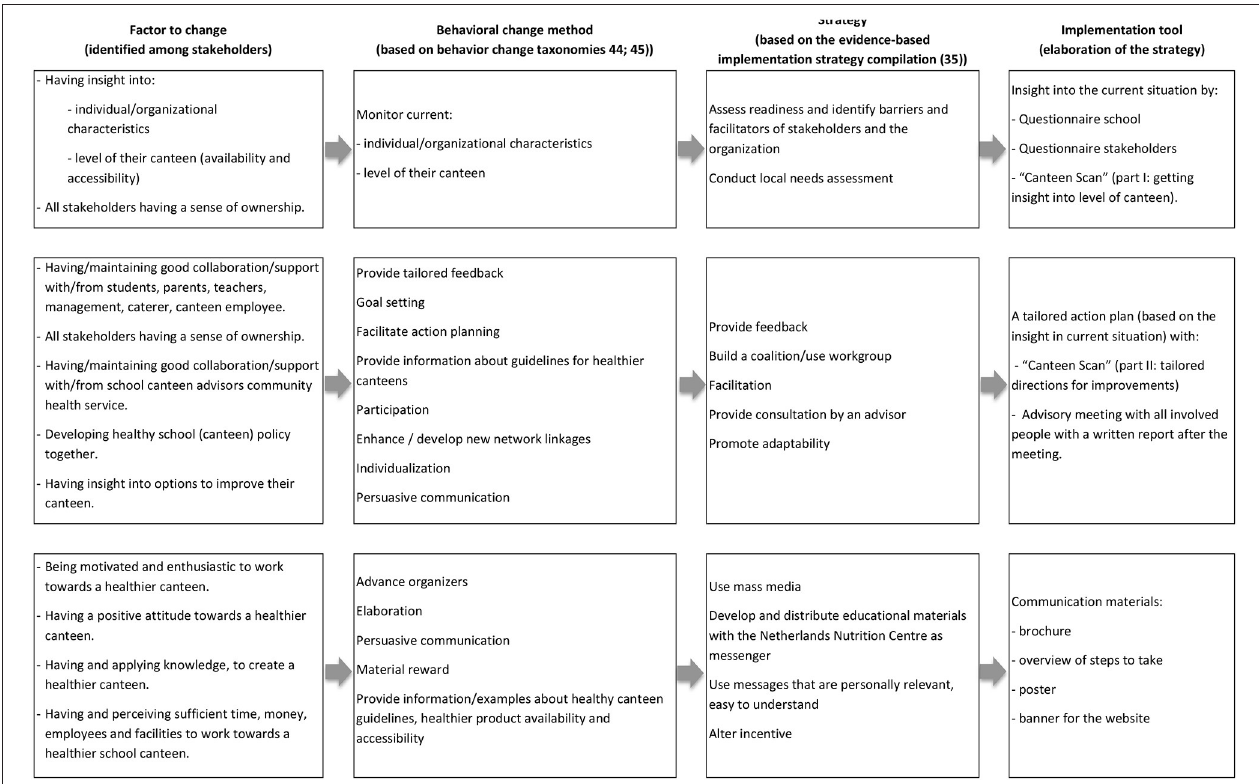
FIGURE 2 | Overview of the translation from factors to implementation tools, via behavioral change methods and